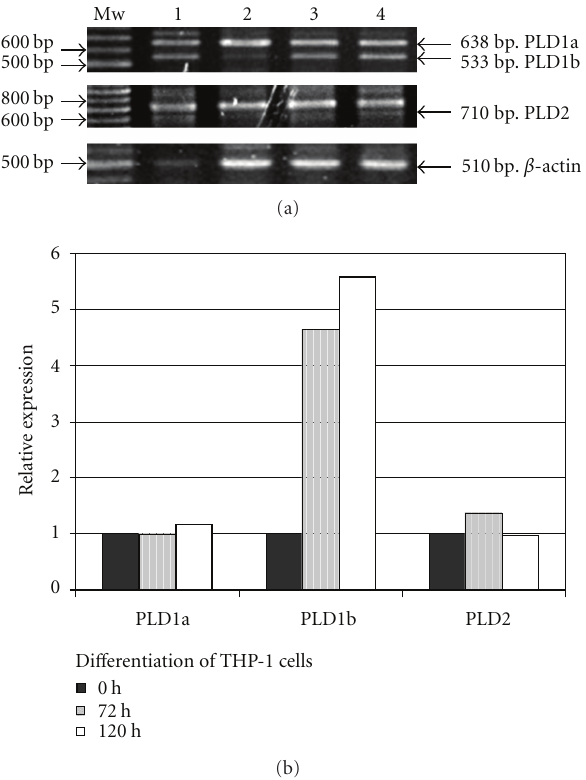
Figure 2: Expression of PLD isoforms in THP-1 cells. RT-PCR with primers specific for di ff erent PLD isoforms (PLD1a 638bp, PLD1b 533 bp, and PLD2 710bp) was performed on total RNA isolated from undi ff erentiated THP-1, THP-1 cells di ff erentiated for 72h and 120h (lanes 2,3, and 4, resp.; lane 1 is the positive con- trol). Band intensities were calculated using BioRad image analysis softwareand fold induction of PLD mRNAs (normalizedto b-actin) relative to undi ff erentiated cells is shown in the lower panel.